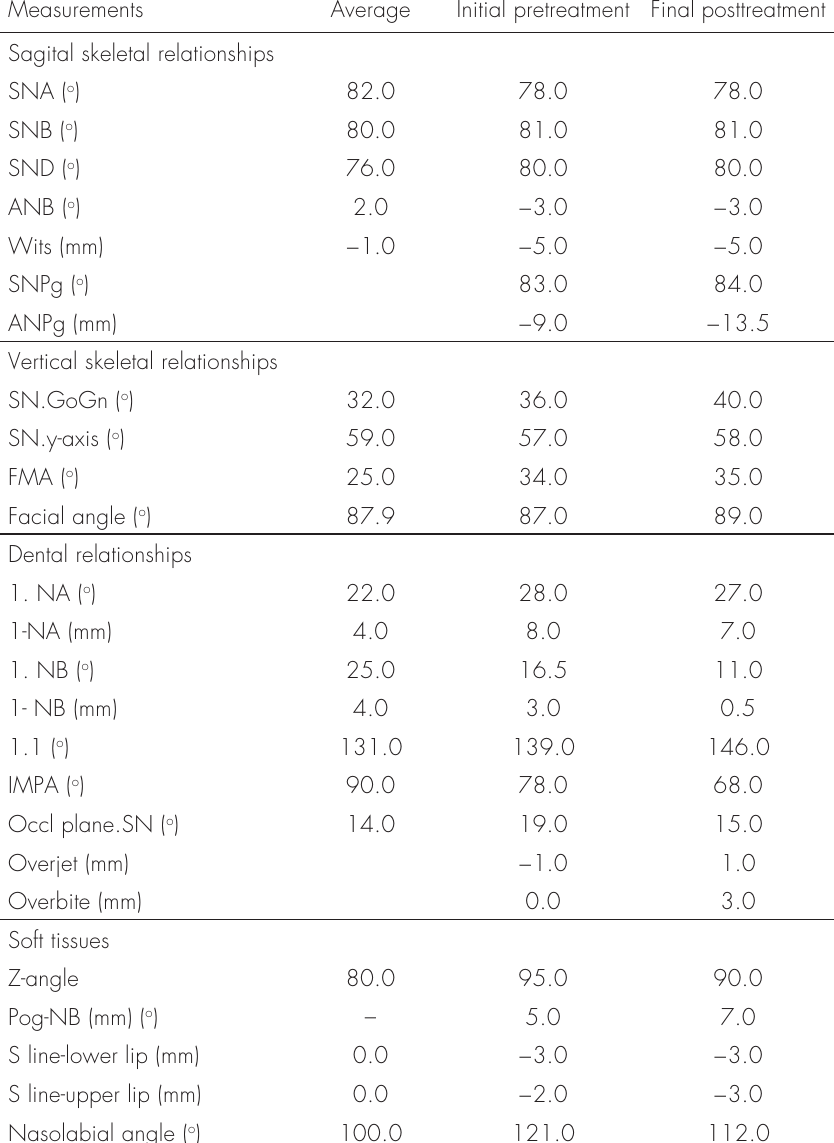
Table I. Initial and final cephalometric